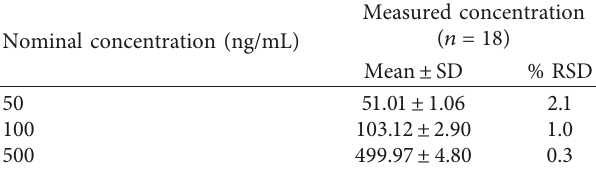
Table 4: Instrumental precision.